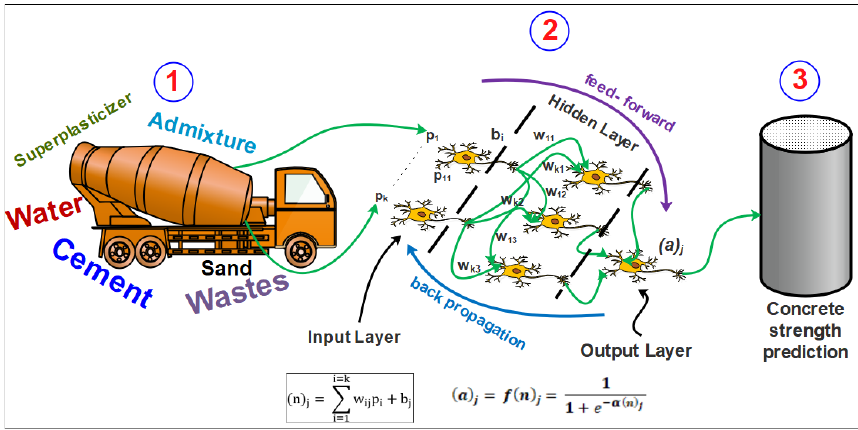
Figure 2. General scheme of the use of ANN for concrete design.